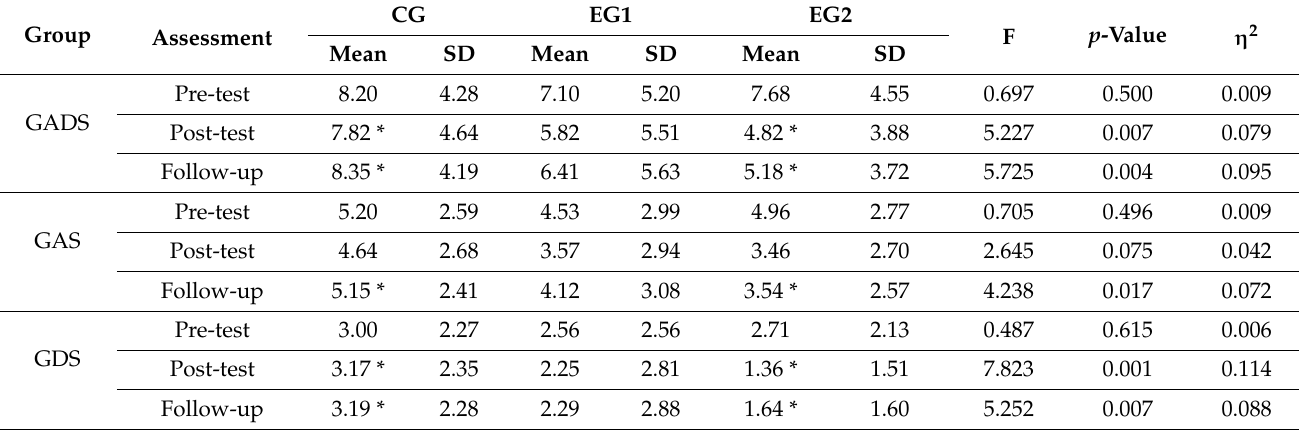
Table 2. Inter-group comparison of GADS, GAS, and GDS at different evaluation moments. One-way ANOVA. Group Assessment